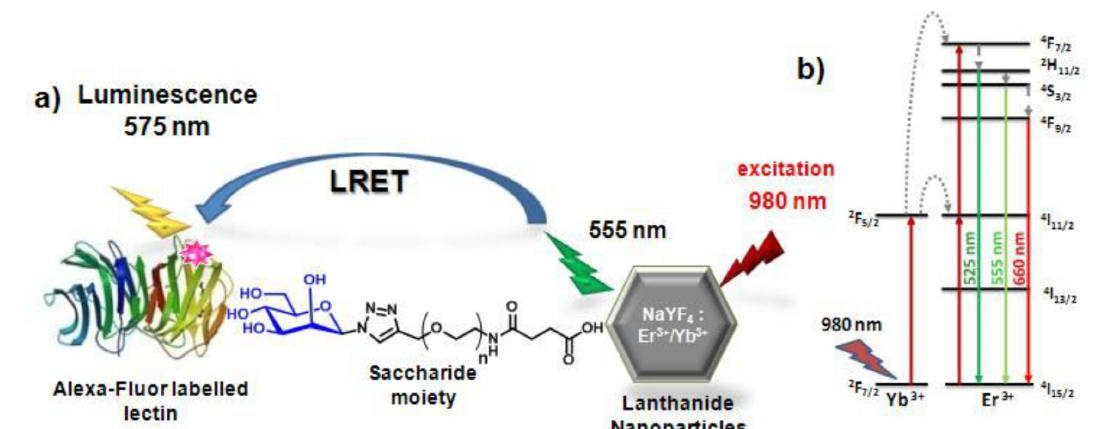
FIGURE 17 – Upconverting lanthanide nanoparticles coated with α -D-mannopyranoside residues anchored to PAMAM dendrimers via thiourea